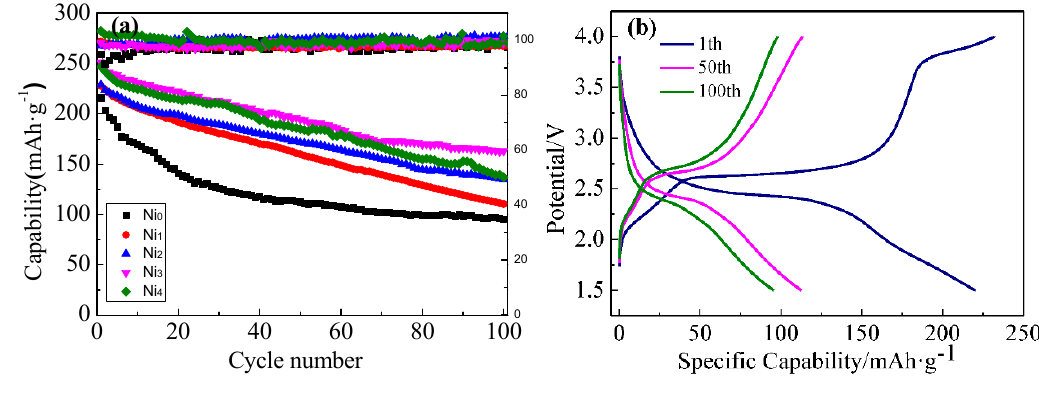
Figure 2. SEM images of ( a ) Ni 0 , ( b ) Ni 1 , ( c ) Ni 2 , ( d ) Ni 3 , and ( e ) Ni 4 , respectively.